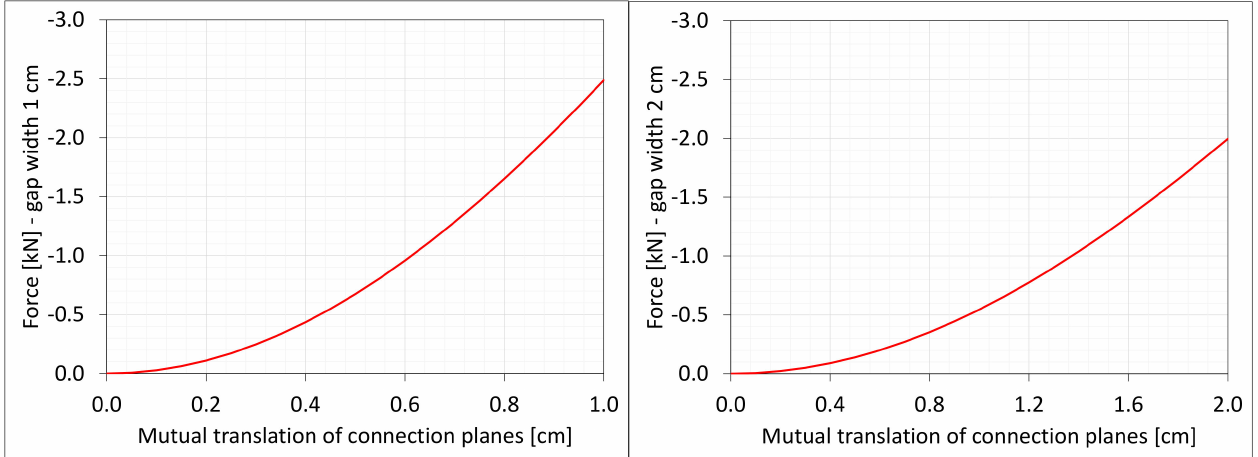
Figure 15. Equilibrium paths for axial force N z . The width of the gap is equal to 1.0 cm, left graphic, and 2.0 cm, right